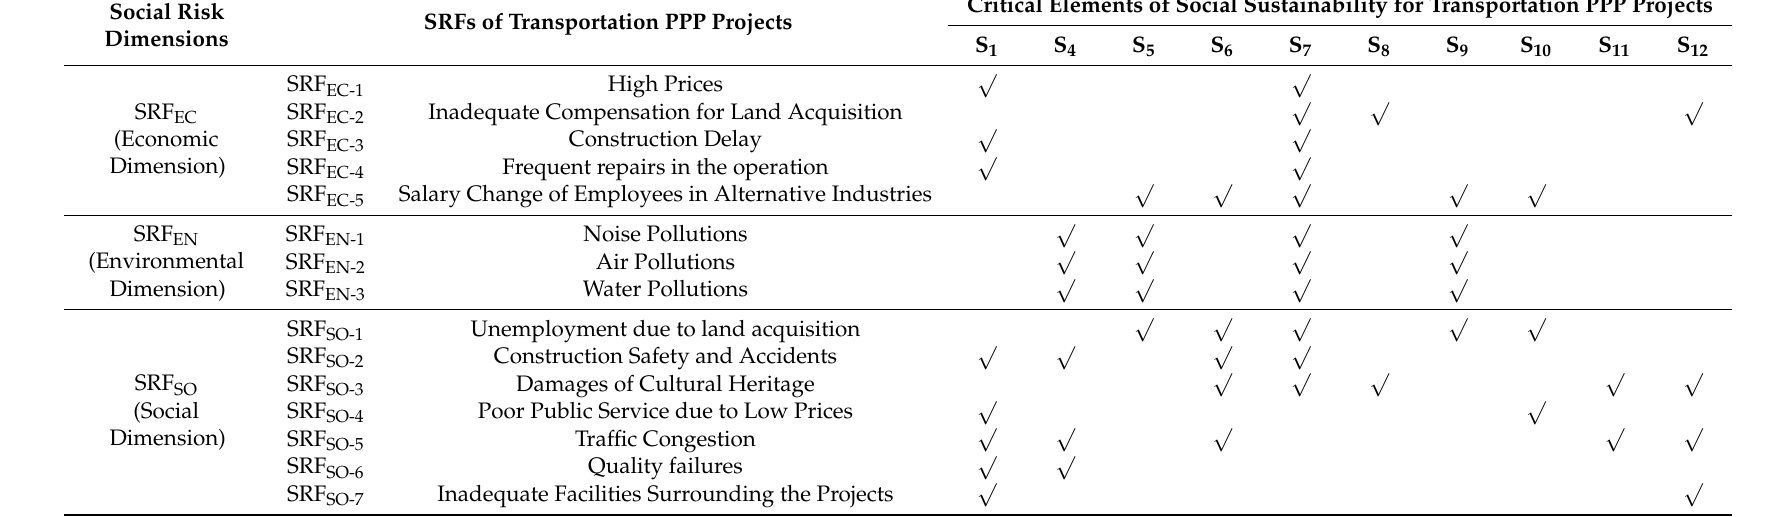
Table 3. The identification of SRFs to achieve the social sustainability of transportation PPP